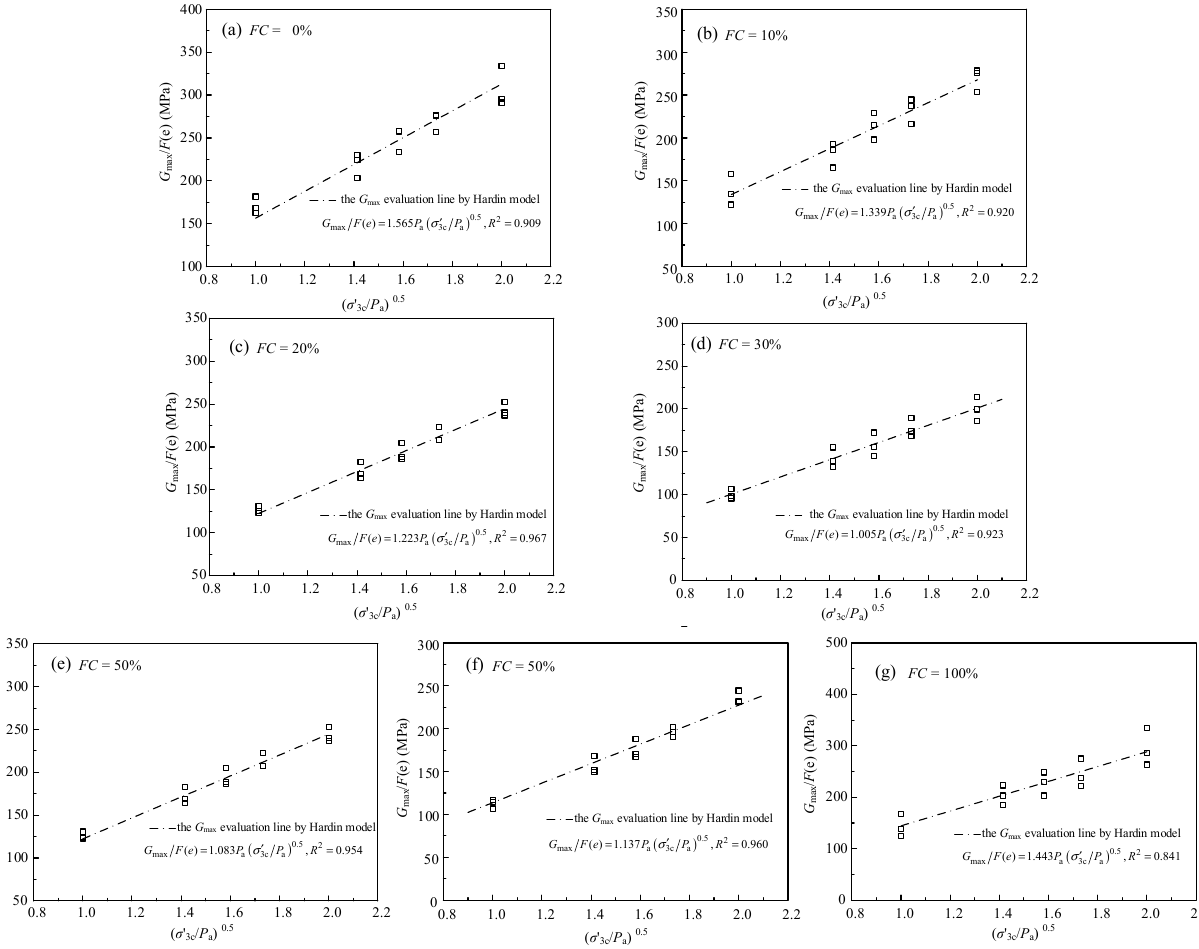
σ′ / P a ) 0.5 the sand-silt mixed soil materials